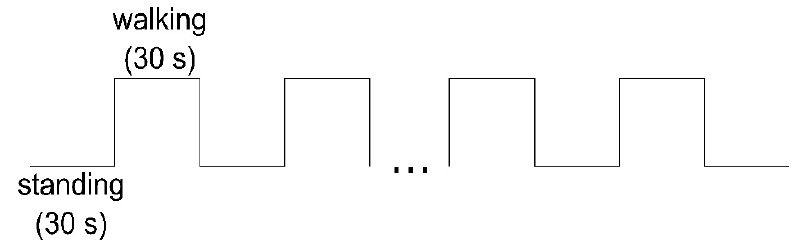
Figure 1. fNIRS test protocol.